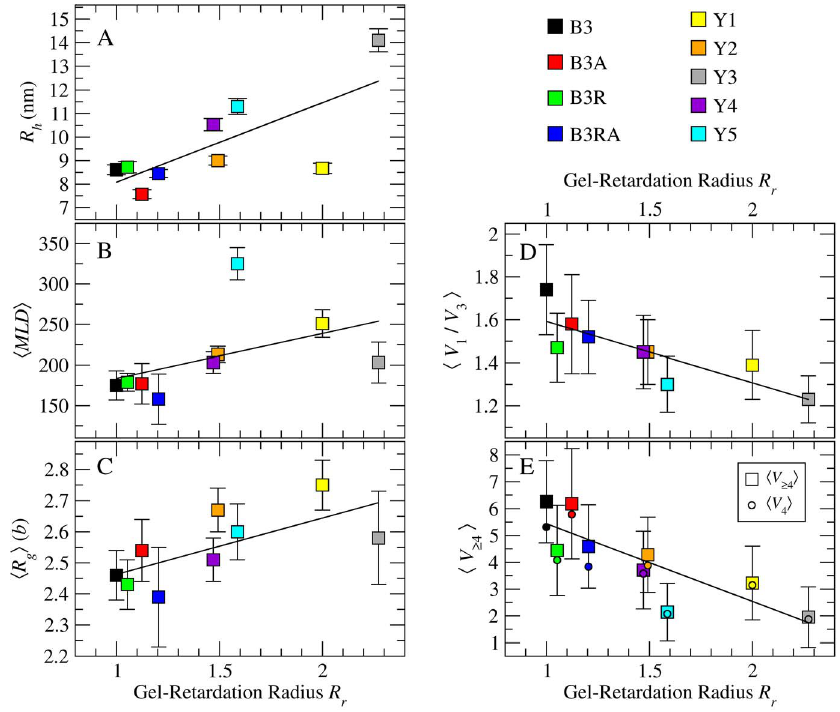
Figure 2. Correlation between measured and predicted size metrics for 2117-nt RNAs. Plotted against gel-retardation radii R r , are: (A) hydrodynamic radii R h , (B) ensemble-averaged maximum ladder distance S MLD T , (C) tree-graph radii of gyration R g , (D) higher-order branching propensity S V 1 T = S V 3 T , and (E) numbers of d =4 (circles) and d $ 4 (squares) vertices. Solid lines are least-squares linear regression fits. Error bars are standard deviations ( s ) except in A, where they are the standard errors of estimates ( s e ). Standard deviations of S V 4 T are listed in Table S1 in File S1.